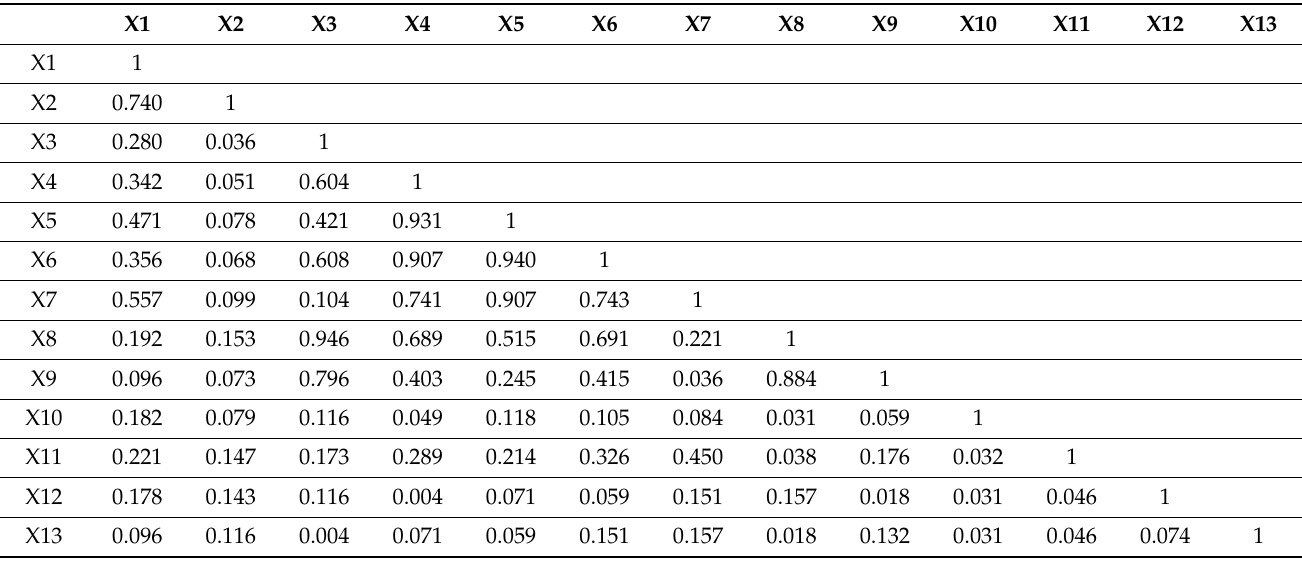
Table 2. Correlation coefficients between the input